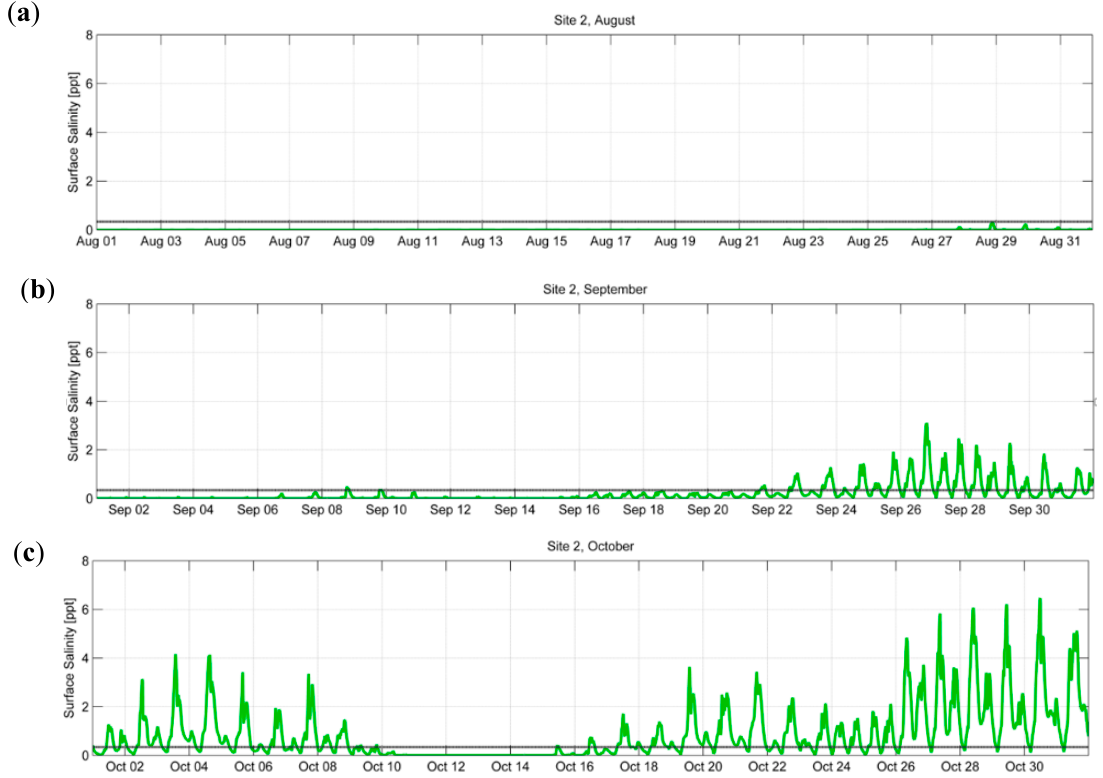
Figure 13. Surface salinity at site 2 between August and October in normal flow year and with 0-m SLR: ( a ) August; ( b ) September; ( c ) October.